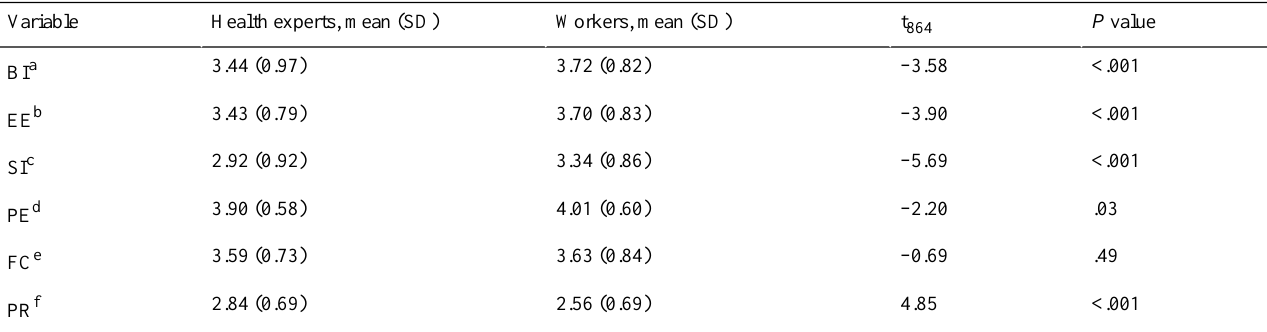
Table 10. Perception differences between